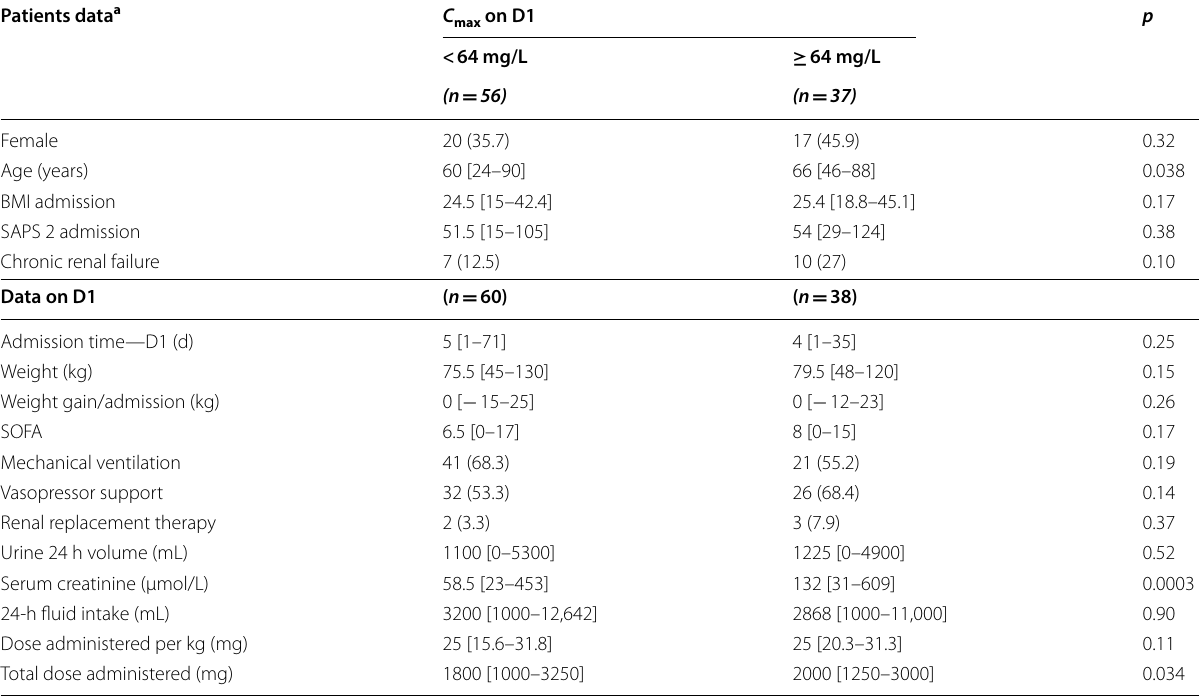
Data expressed in n (%) or median [min–max] a Comparison according to the C max measured during the first episode of infection treated with amikacin